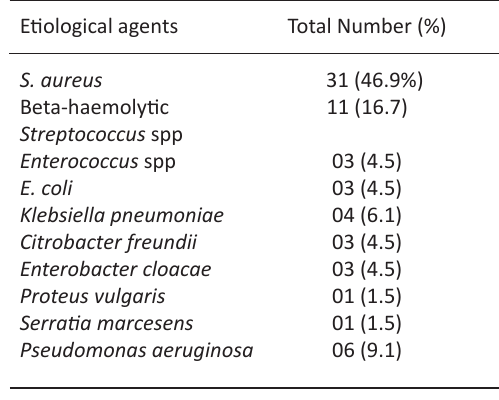
Table 2. Etiological agents of OM